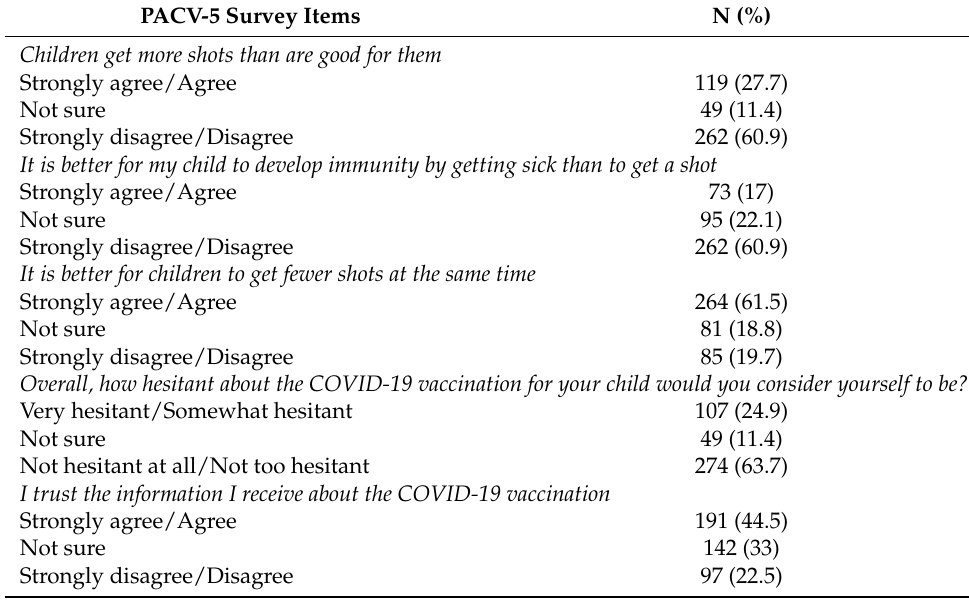
Table 3. Distribution of COVID-19 vaccine hesitancy using the PACV-5 survey tool. PACV-5 Survey